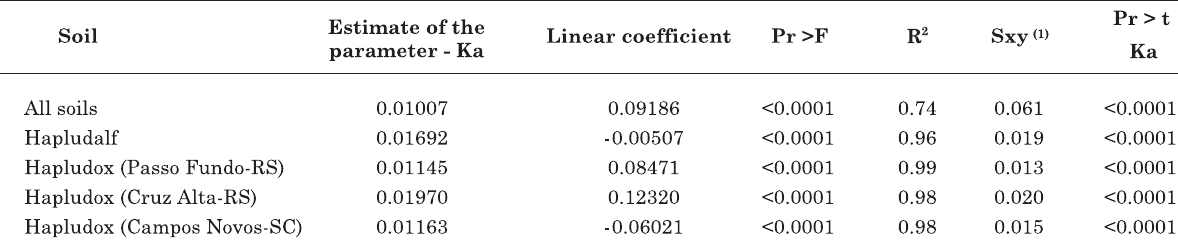
Table 2. Analysis of variance for the linear